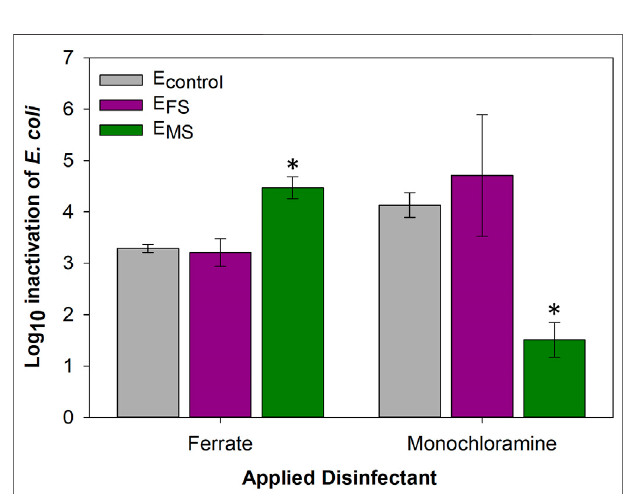
FIGURE 6 | E. coli log 10 inactivation of controls and evolved (E FS and E MS ) cultures cross-disinfected with ferrate or monochloramine at the 18th disinfection round. Single asterisks (*) represent statistical signi fi cance ( p- value < 0.05) compared to E control cultures treated with the respective disinfectant. Error bars represent one standard deviation of at least triplicate